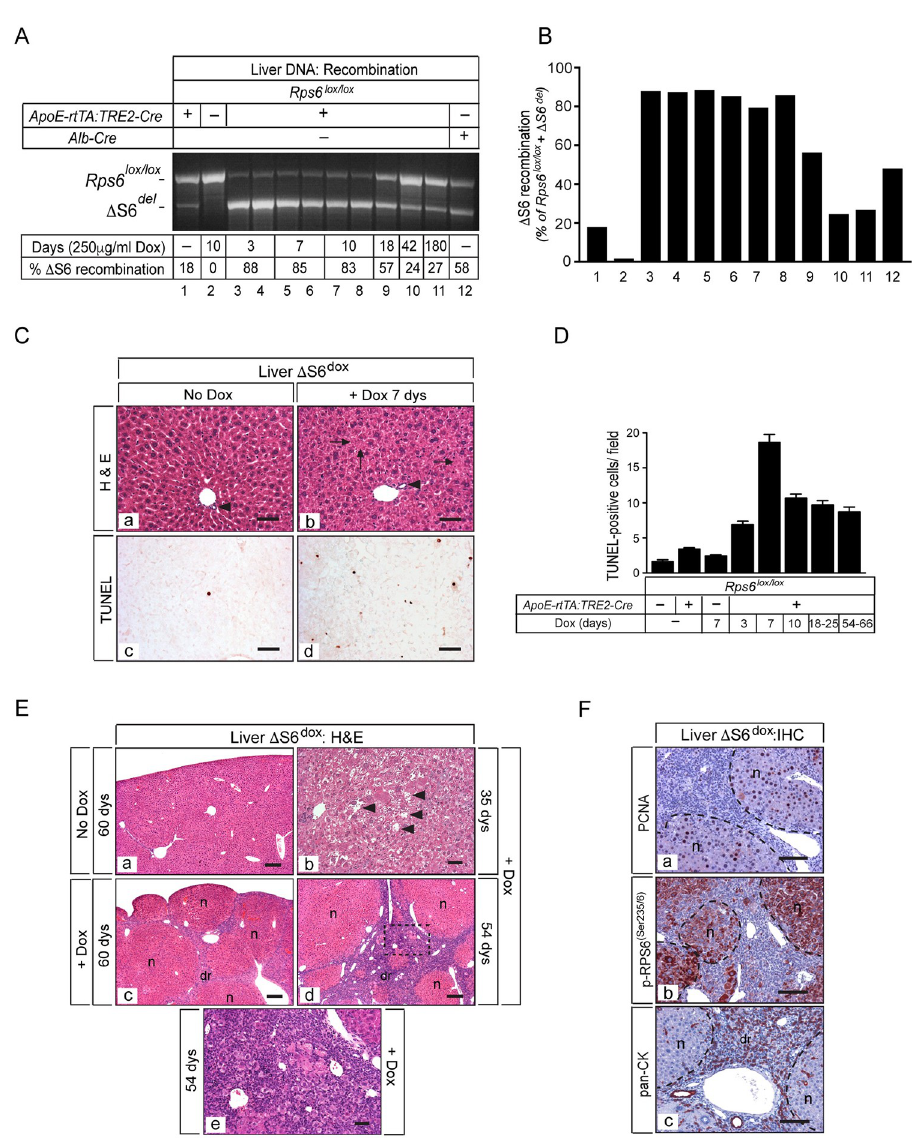
Fig 4. Deletion of Rps6 in adult liver induces hepatocyte apoptosis and triggers regeneration. (A) Ethidium-stained gel showing recombination of the Δ S6 allele in livers of Δ S6 dox mice with and without dox (250 μ g/ml) for different lengths of time. (B) Graph of quantitation of % Δ S6 recombination from gel shown in A). While there is a low level of recombination (~18%) in the absence of dox (lane 1), it increases to ~85% when mice are provided with 250 μ g/ml dox representing loss of Rps6 in a majority of hepatocytes, the most abundant cell type in the liver (lanes 3–8). After ~3 weeks, the extent of recombination begins to decrease reflecting the loss of Rps6-deficient hepatocytes and their replacement with Rps6-expressing cells (lanes 9–11) (see F below). Note that the degree of recombination achieved in livers of Rps6 lox/lox : ApoE-rtTA : TRE-Cre mice (provided with dox) before widespread hepatocyte loss occurs (lanes 3–8) is consistently greater than that achieved in livers of Rps6 lox/lox : Alb-Cre mice (lane 12). (C) Photomicrographs of H&E staining (a and b) or TUNEL staining (c and d) on sections of Δ S6 dox livers provided with water (a, c) or water containing 250 μ g/ml dox (b, d) for 7 days (Original magnifications, all x187; scale bars 50 μ ). While bile ducts are present and appear normal in Δ S6 dox livers (arrow heads), hepatocytes appear disordered, show mild vacuolization and some lack nuclei (arrows). (D) Graph showing quantitation of number of TUNEL-positive cells/field in liver sections of WT and Δ S6 dox mice provided with dox for different lengths of time. (E) Photomicrographs of H&E stained sections of Δ S6 dox livers provided with water (a) or 250 μ g/ml dox for different lengths of time (b-f). After ~35 days on dox, hepatocyte blebbing and focal drop-out is visible (b), followed by a full-blown regenerative response involving the emergence of regenerative nodules (n) and a ductular reaction (dr) (c-e). Image in (e) is a higher magnification of the area in (d) bounded by the dotted line (Original magnifications, a, c, d (x31.25); b, e (x125)). Scale bars: a), c) and d), 100 μ ; b) and e), 50 μ . (F) Photomicrographs of IHC for PCNA, phospho-RPS6 (Ser235/6) and pan-cytokeratin (CK)